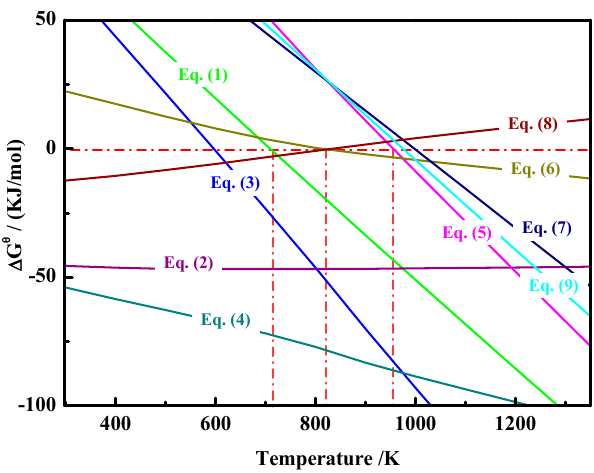
Figure 4. Correlation between standard Gibbs free energy and temperature for Equations (1)–(9).